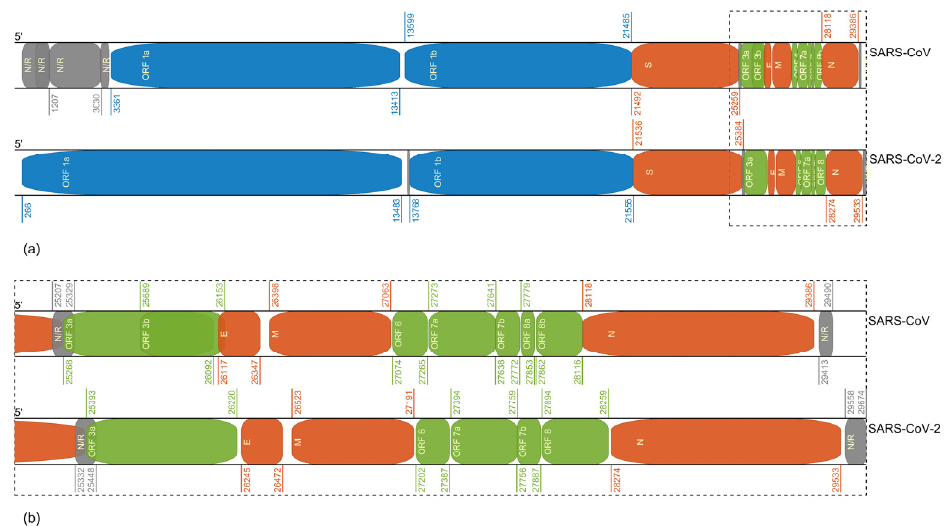
Figure 1. Open reading frames (ORF) organization in SARS-CoV-2 (GenBank: MN908947.3) and SARS-CoV (GenBank: AY394850.2) ( a ) The genome organization in complete sequence. ( b ) The enlarged diagram shows ORFs (no less than 75 nt in length) in SARS-CoV-2 and SARS-CoV genomes after 25,000 nt in sequence.